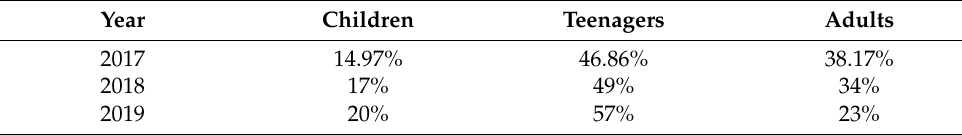
Table 3. Population distribution, data from [19].